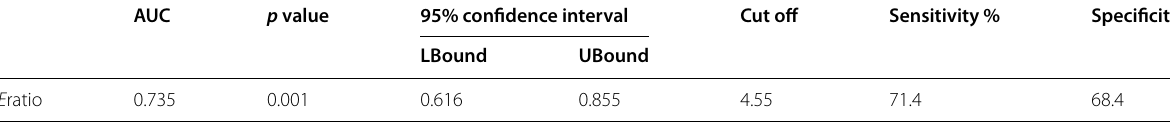
Table 3 The calculated E ratio cut-off point to differentiate benign from malignant lesions AUC p